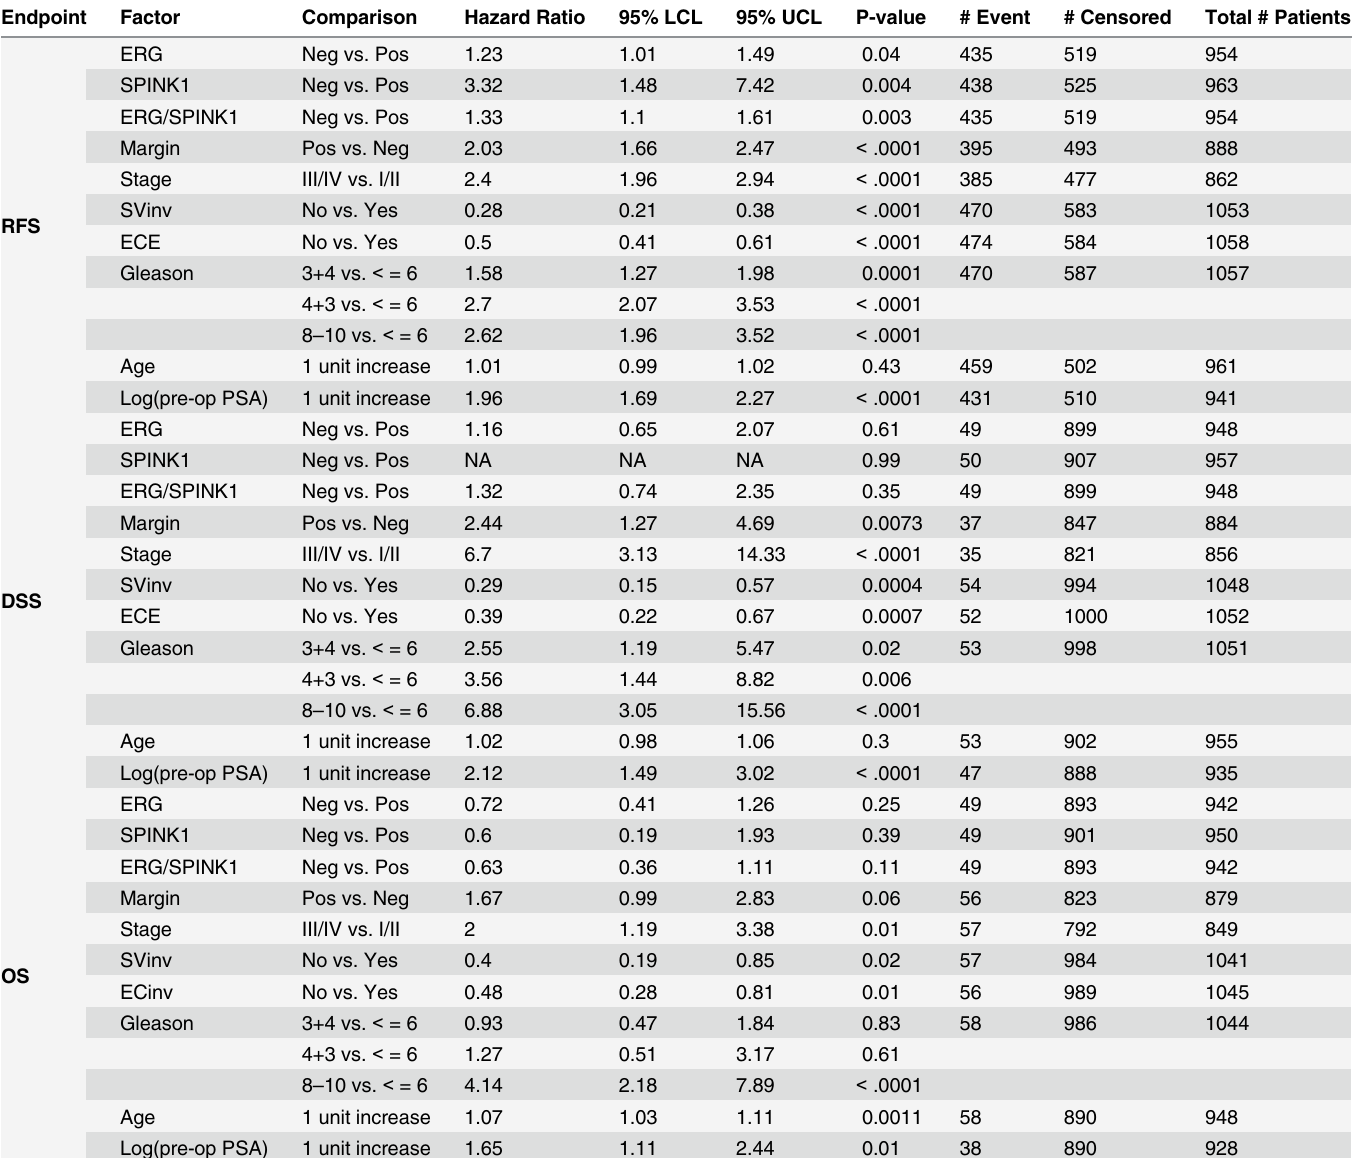
Table 3. Univariate Cox proportional hazard